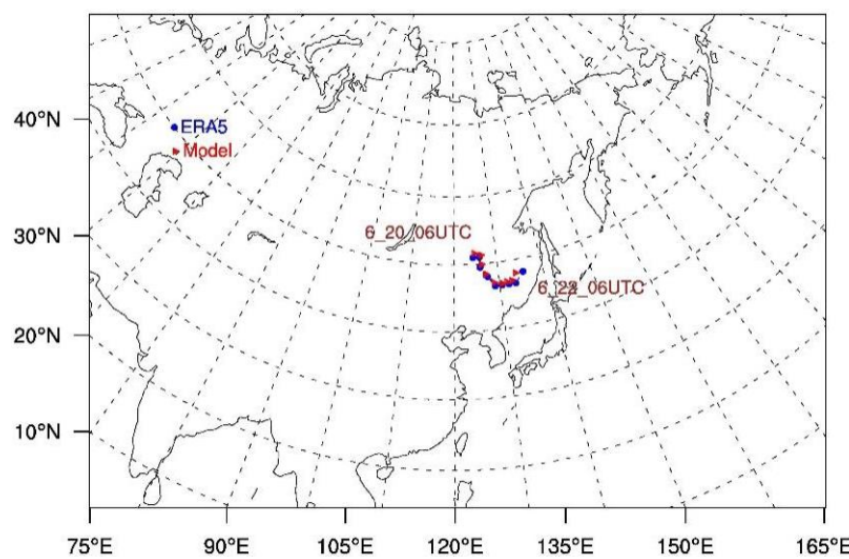
Figure A1. Domain of the model, and tracks of the simulated (blue dots ‘ • ’) and the real (red triangles ‘ (cid:78) ’) cut-off low. The horizontal axis is longitude, and the vertical axis is